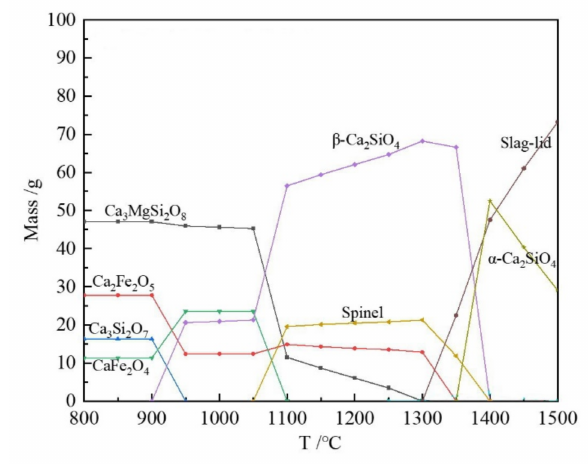
Figure 1. Phase equilibrium diagram of slag oxidized.